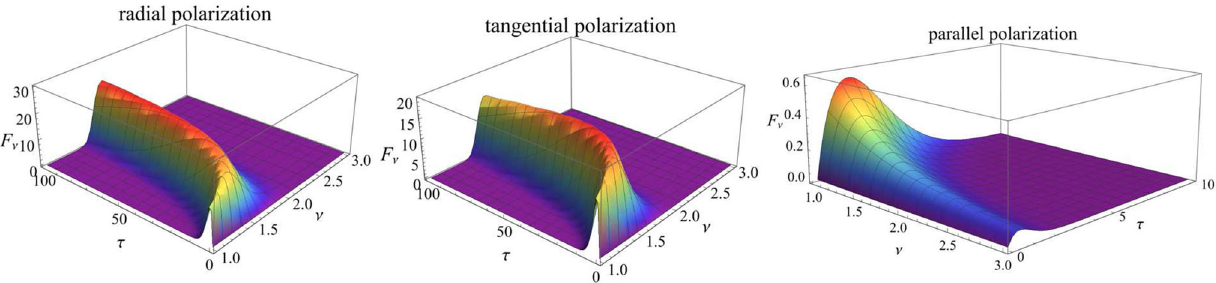
effective distance r = 0 . 1. Here F ν and ν are dimensionless. θ is the state parameter, which is expressed in radian. τ and r are also dimen- sionless by rescaling, actually r is in the unit of c ω ,ζ α ,ζ ) = ( 0 , 1 , 0 ) and the of 1 γ r z